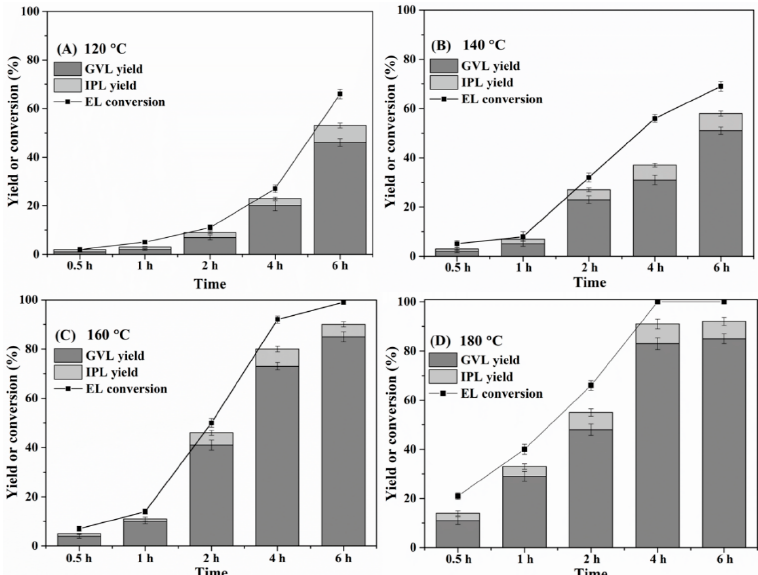
Figure 7. Effect of reaction temperature (120–180 ◦ C) and time on the conversion of EL to GVL. Reaction conditions: EL, 1 mmol; PPOA–Hf-1:1.5, 72 mg; and 2-propanol, 5